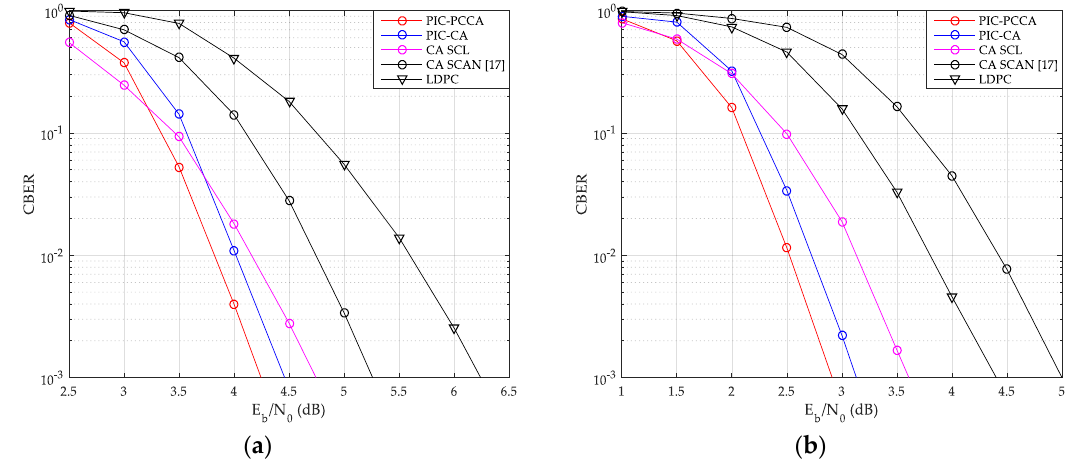
Figure 13. CBER of SCMA over AWGN channel. ( a ) K = 100, R = 1/2; ( b ) K = 64, R = 1/3.